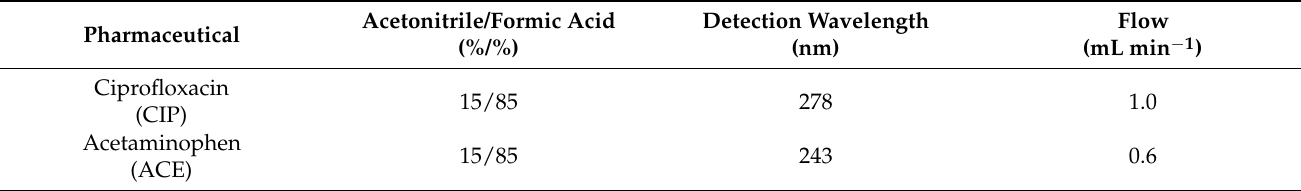
Table 3. Chromatographic conditions for analyses of CIP and